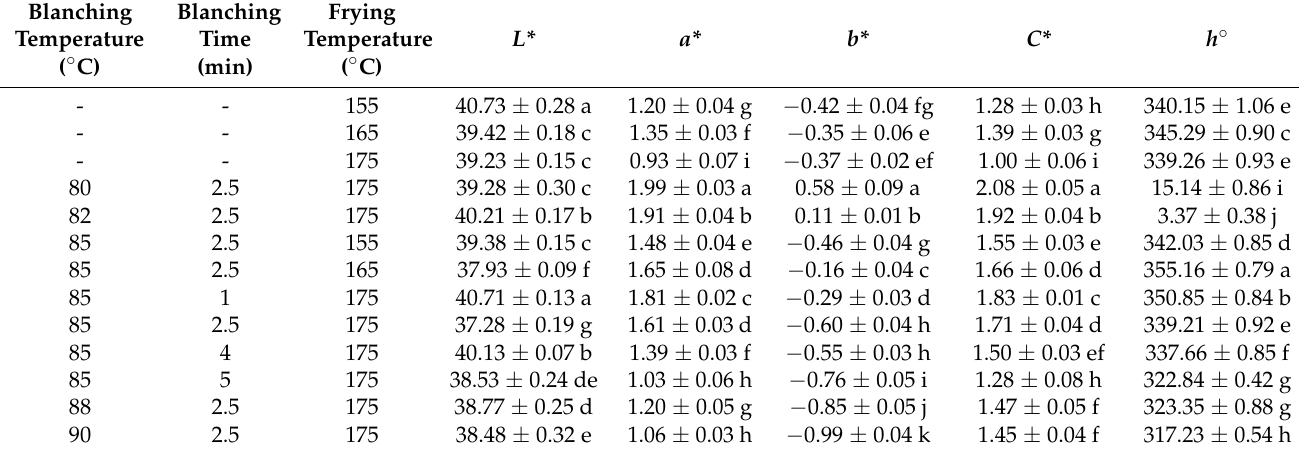
Table 4. Color parameters of potato crisps ( cv. Provita), depending on technological